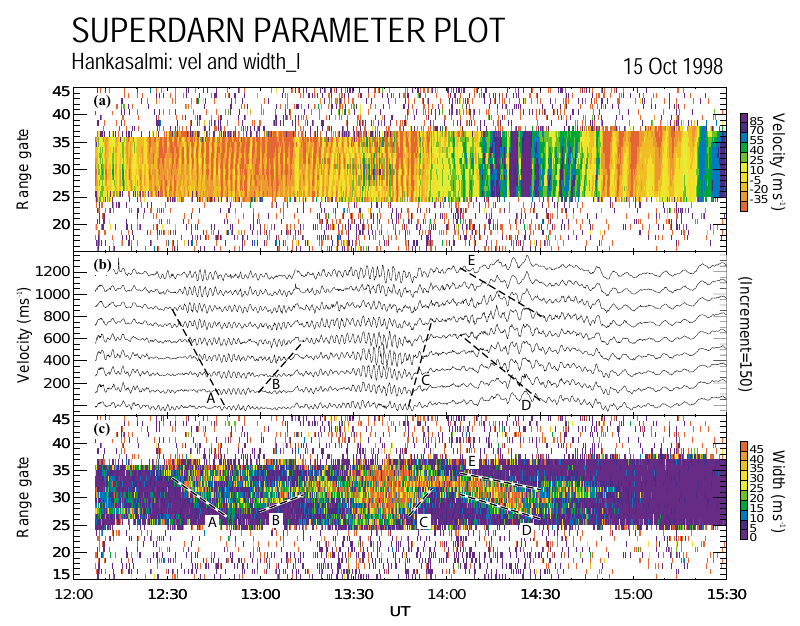
Fig. 3. High spatial and temporal res- olution CUTLASS Finland radar mea- surements of artificially induced irreg- ularities during the OUCH experiment on 15 October 1998. Panels include: (a) colour-coded line of sight velocity along beam 5 (positive velocities are towards the radar); (b) stacked veloc- ity time series taken from range gates 26–34 as shown in (a); (c) colour- coded spectral width associated with the backscattered signals derived us- ing the ACF fitting routine fitacf. The dashed lines, A-E, indicated common spatial boundaries apparent in panels (b) and (c). Data in all these panels have a 10s and 15km